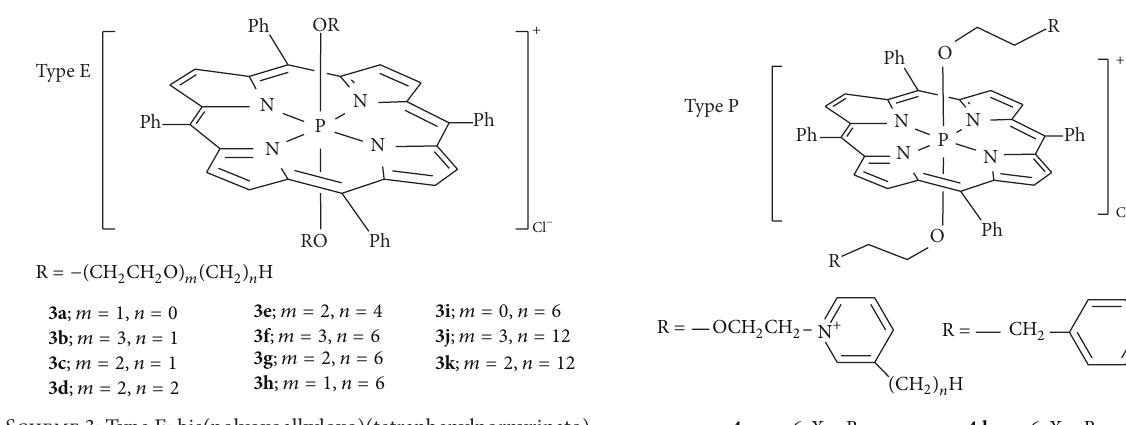
Scheme 3: Type E: bis(polyoxoalkyloxo)(tetraphenylporpyrinato) phosphorus ( 3 ).